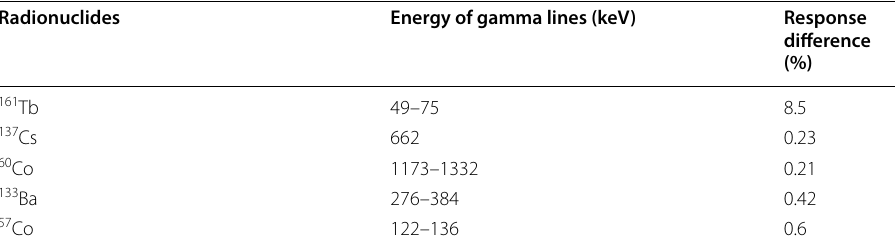
Table 3 Response difference comparison of the ionization chamber measurements of 161 Tb, 137 Cs, 60 Co, 133 Ba and 57 Co solutions in Eppendorf tubes and sterile glass vials Radionuclides Energy of gamma lines (keV) Response